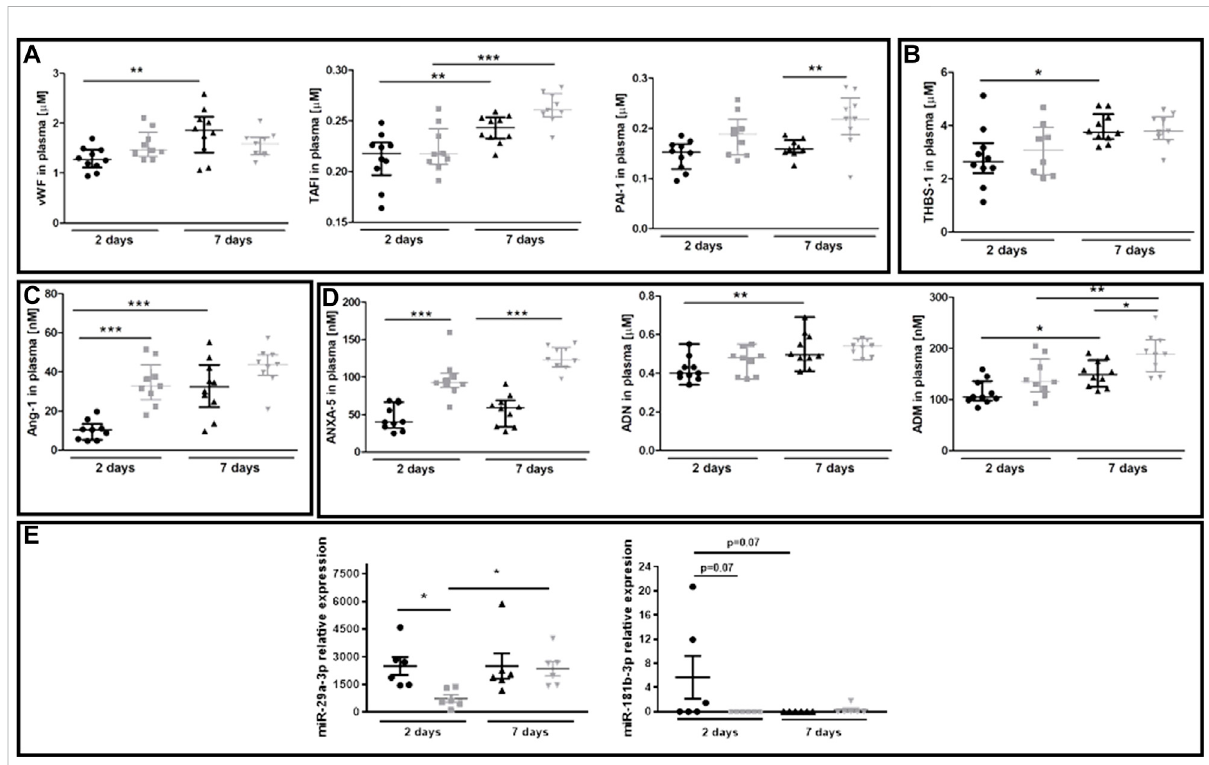
FIGURE 6 Plasma endothelial dysfunction and EndMT biomarkers in 20-week-old and 40-week-old BALB/c mice after i.v. injecton of 4T1 breast cancer cells. Black symbols denote 20-week-old mice, and grey symbols denote 40-week-old mice. Plasma markers of (A) endothelium in fl ammation and hemostasis (vWF, TAFI, and PAI-1) ( n = 9 – 10), (B) platelet activation (THBS-1) ( n = 9 – 10), (C) endothelium permeability (Ang-1) ( n = 9 – 10), and (D) other biomarkers of endothelial function (ANXA5, ADN, and ADM) are shown two and seven days post-injection of 4T1 breast cancer cells ( n = 9 – 10). (E) RelativeplasmaexpressionlevelsofpotentialEndMTmarkers miR-29a-3p and miR-181b-3p ( n =6).DataareshownasthemedianandIQR and were compared with parametric two-way ANOVA. Key: * p < 0.05; ** p < 0.01; *** p <